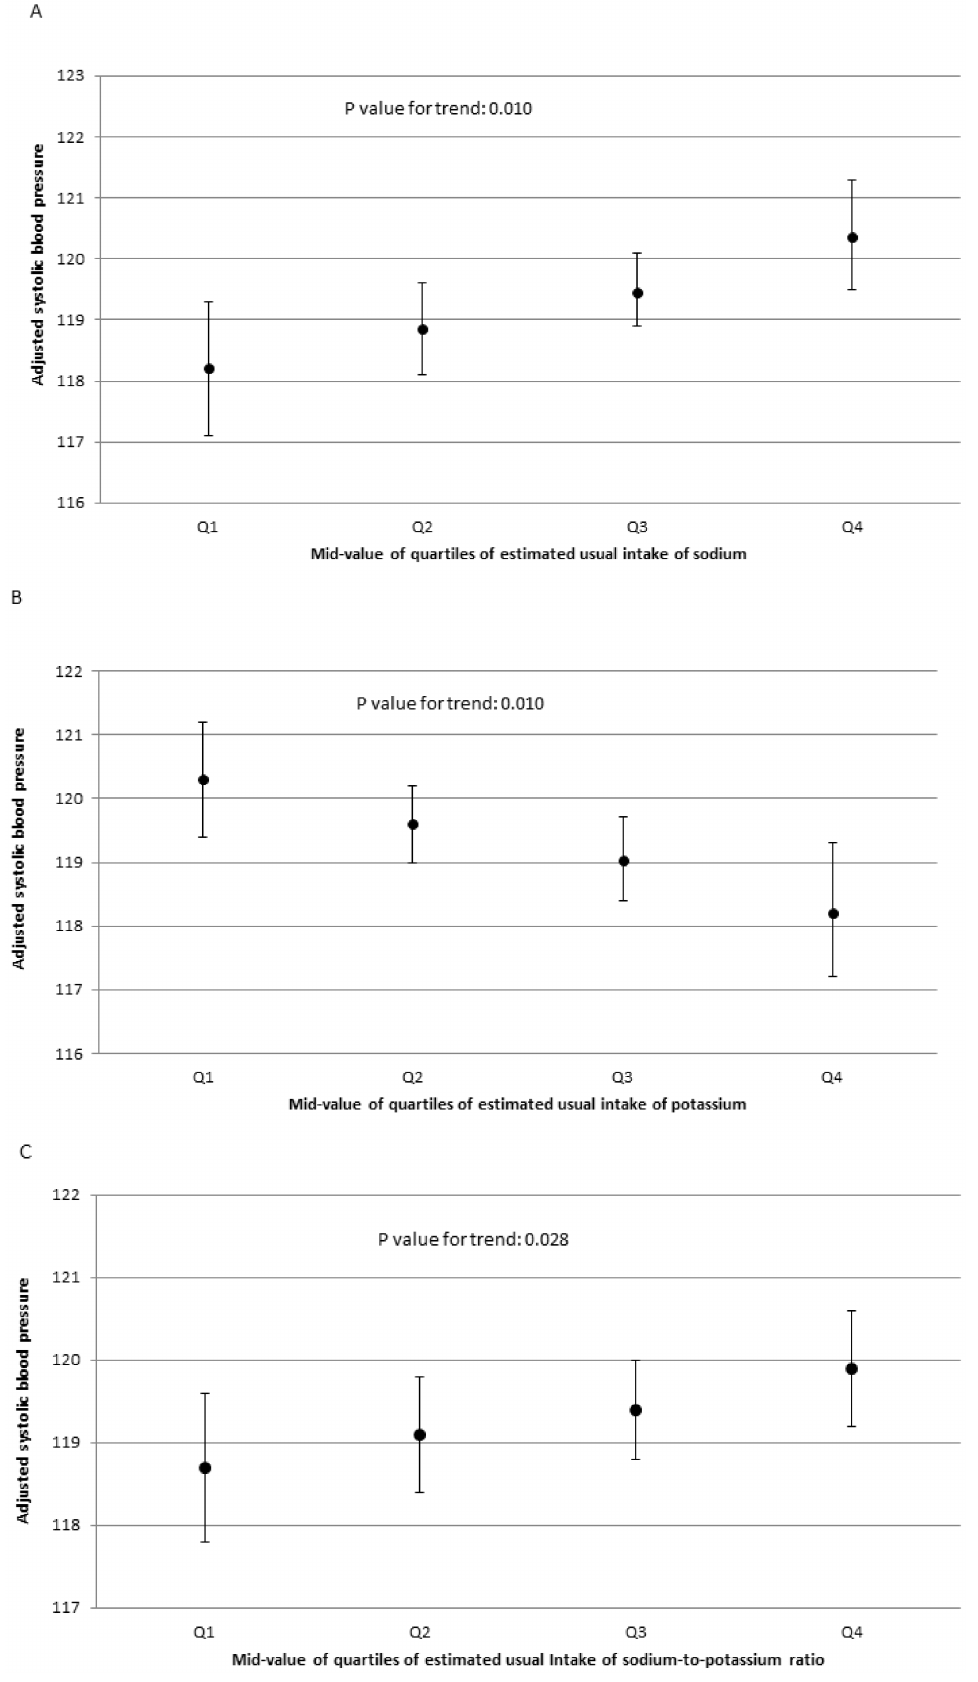
Figure 2. Adjusted systolic blood pressure (95% confidence interval) by mid-value of quartile sodium, potassium intake and their ratio among adults aged $ 20 years who were not taking antihypertensive medication, NHANES 2005–2010. doi:10.1371/journal.pone.0075289.g002 PLOS ONE | www.plosone.org 8 October 2013 | Volume 8 | Issue 10 |